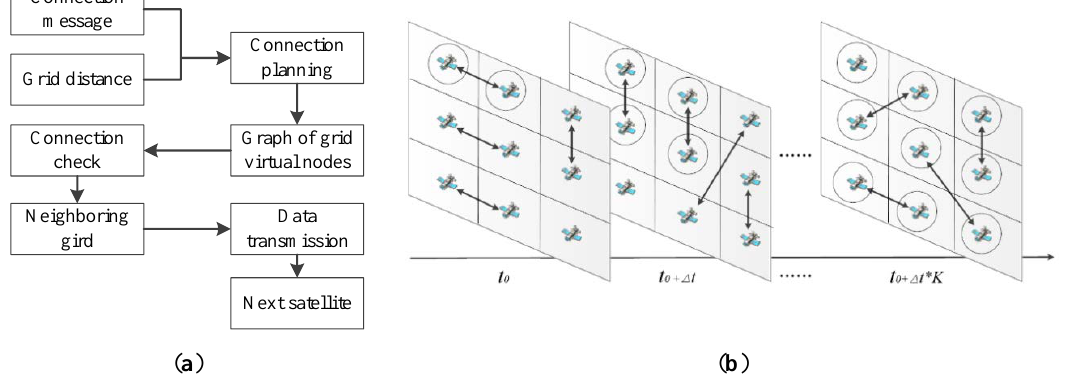
Figure 8. Dynamic routing planning method: ( a ) routing method; ( b ) topology of time-slice based on grids.